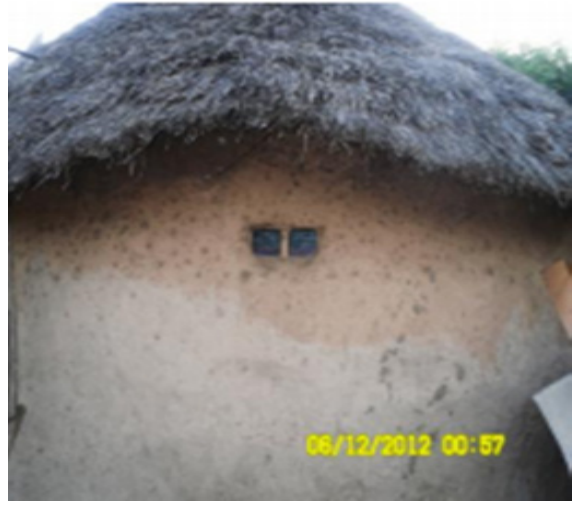
Figure 7. Narrow windows .